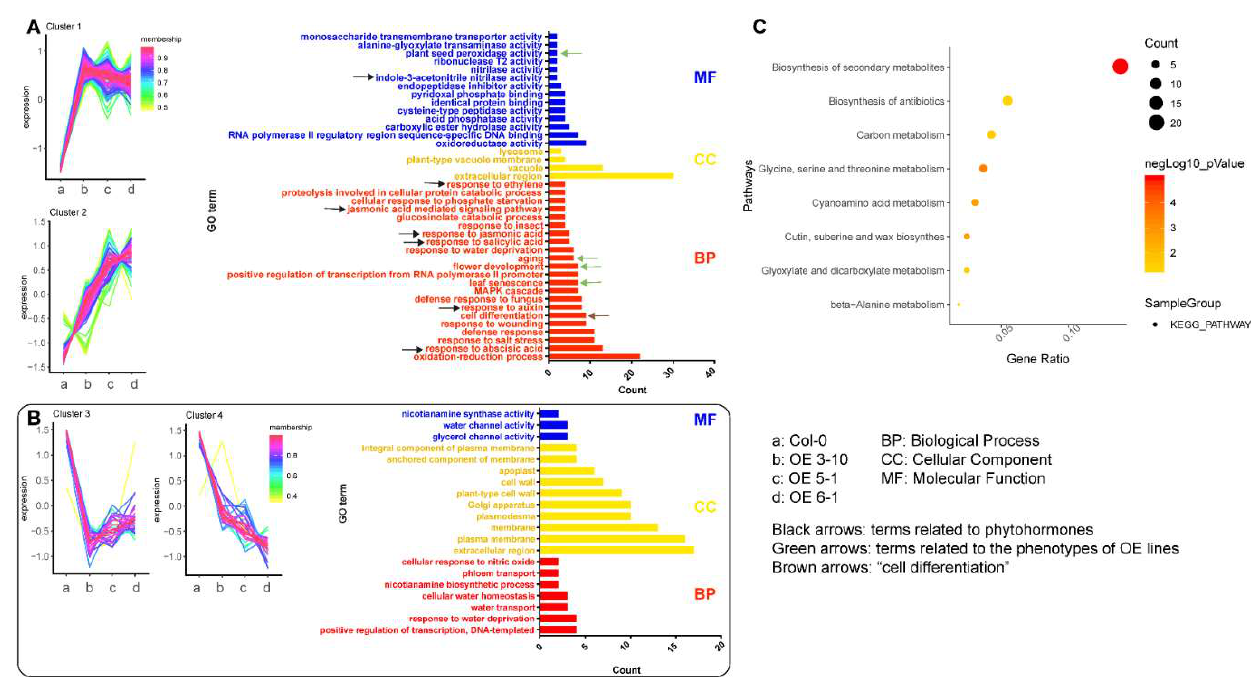
Figure 7. Transcriptome analysis of WT and OE-CsFLC1 lines. ( A ) Gene cluster and GO enrichment of upregulated genes in OE-CsFLC1 lines compared to WT. ( B ) Gene cluster and GO enrichment of downregulated genes in OE-CsFLC1 lines compared to WT. ( C ) KEGG enrichment of upregulated genes in OE-CsFLC1 lines compared to WT.